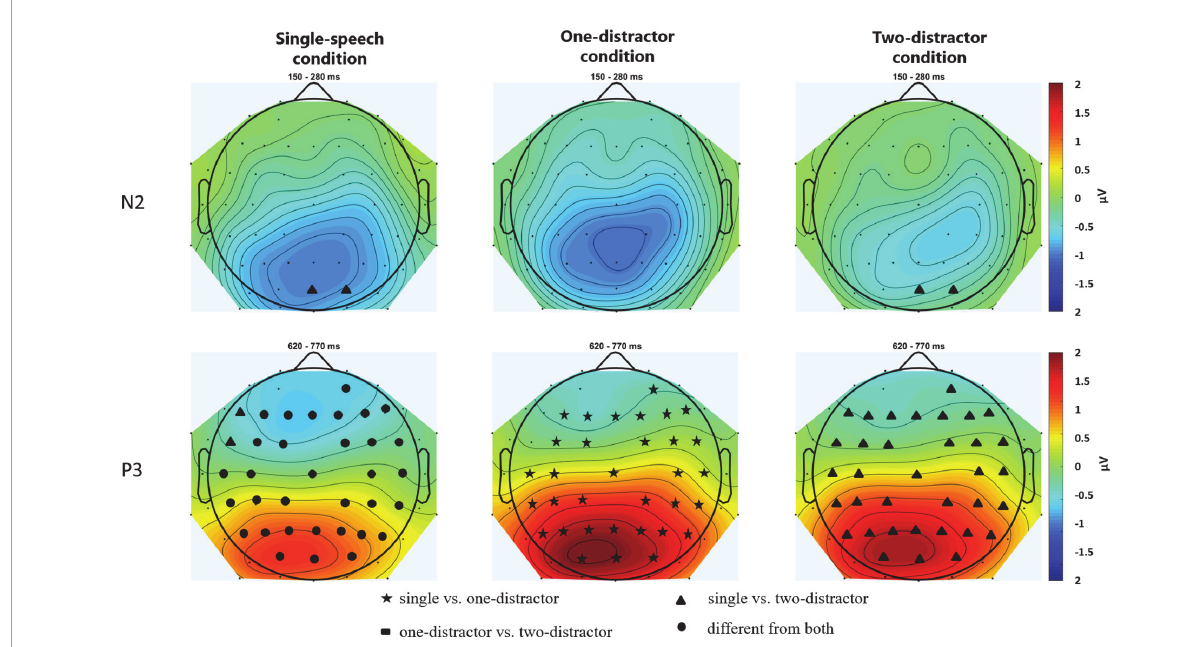
FIGURE3 Scalp topography of the N2 (upper row) and P3 (bottom row) component for target numerals in the three experimental conditions: single-speech (left) , one-distractor (middle) , and two-distractor (right) . The scalp distributions were calculated from the average voltages measured from the time windows shown in Figure 2 . Maps were spline interpolated with a smoothing factor of 10 − 7 . Electrode locations marked by filled circles, stars, triangles, and rectangles represent the scalp locations where the signal in the given latency range significantly differed from one (filled stars, rectangles, or triangles) or both (circles) other conditions. Tests were computed by pair-wise post hoc comparisons of the corresponding ANOVA with the factors of CONDITION and ELECTRODE LOCATION (including all electrodes; thus replacing the factors ANTERIOR-POSTERIOR and